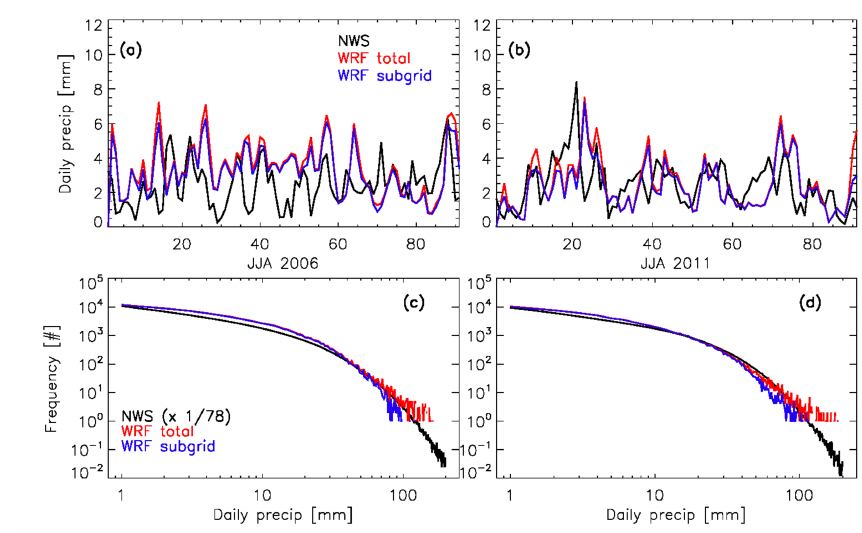
Fig. 3. Time series and frequency distributions for JJA 2006 and 2011 area-averaged daily precipitation within the analysis region (see Fig. 1). Distributions for NWS are scaled by the ratios between total grid counts in WRF at 36km and total grid counts in NWS within the analysis boundaries ( ∼ 1 / 78). WRF subgrid is the portion of precipitation from subgrid cumulus parameterization. Only grid points with more than 1 mm of precipitation are